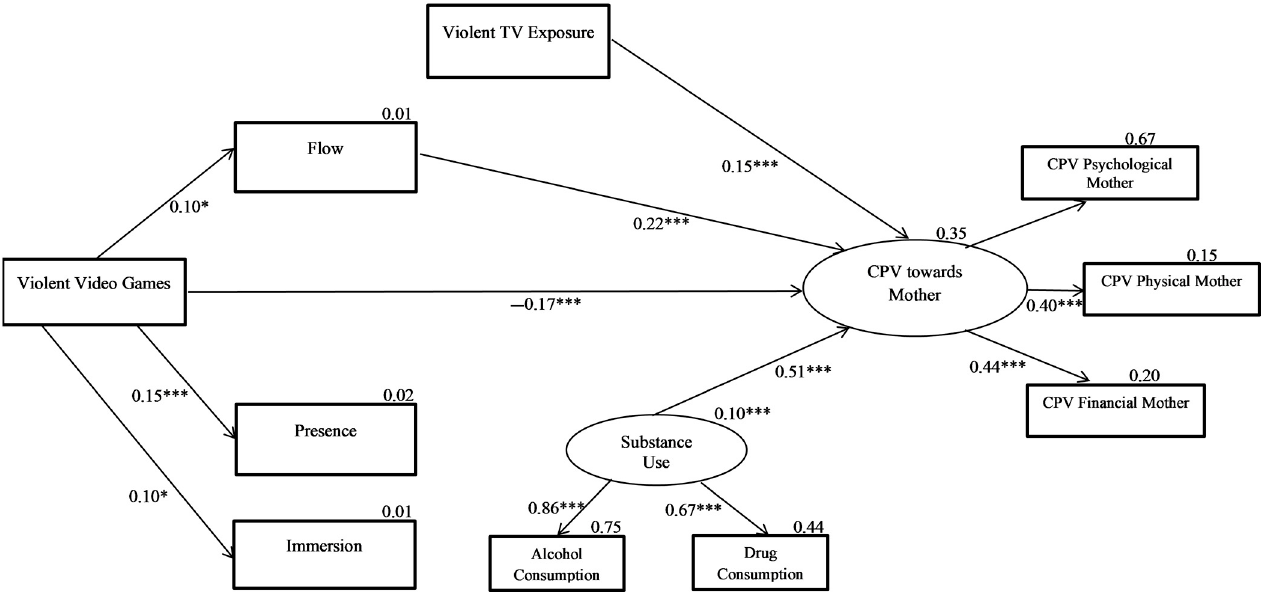
Table 4. Standardized effects of substance use, violent video games and engagement on CPV to- wards fathers (final model).